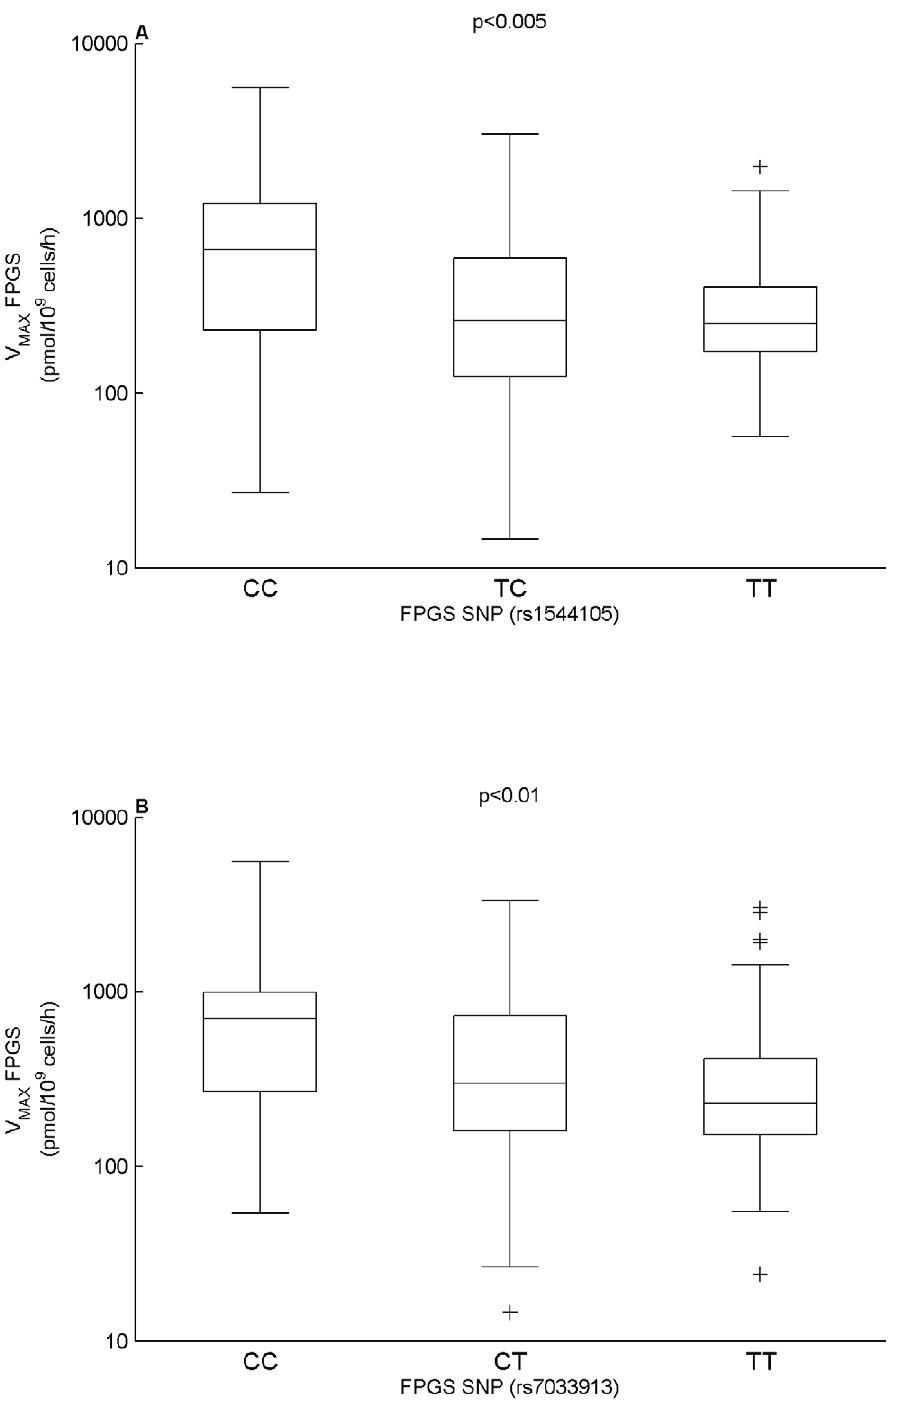
Figure 5. MTXPG model parameters vs germline SNPs. ( A ) V MAX FPGS vs FPGS SNP (DB SNP ID: rs1544105). ( B ) V MAX FPGS vs FPGS SNP (DB SNP ID: rs7033913). The p-values were determined by the Kruskal-Wallis